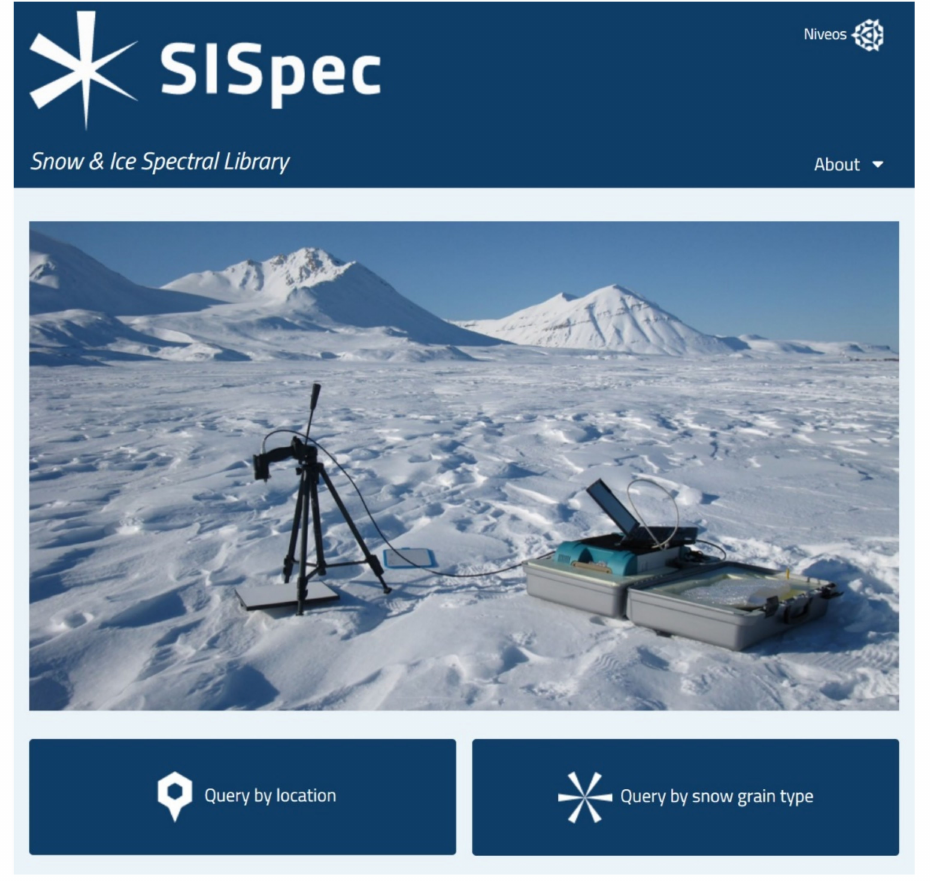
Figure 4. The search features of the SISpec web